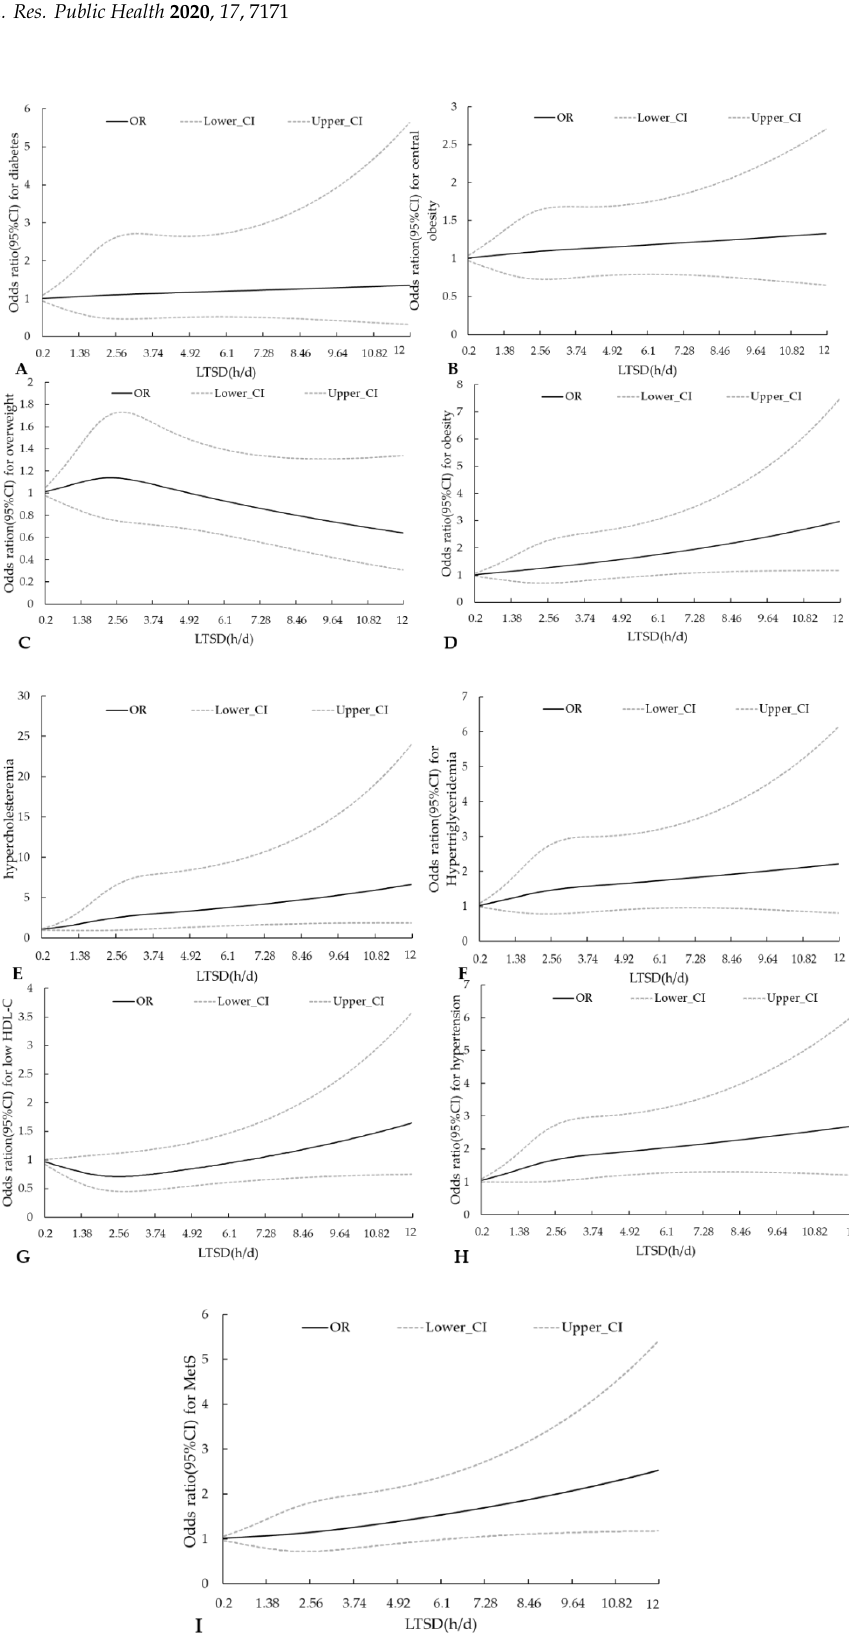
Figure 1. Restrictive cubic spline (RCS) curves for sedentary duration and ( A ) diabetes, ( B ) central obesity, ( C ) overweight, ( D ) obesity, ( E ) hypercholesterolemia, ( F ) hypertriglyceridemia, ( G ) low HDL-C level, ( H ) hypertension, and ( I ) metabolic syndrome (MetS). Region, education, income, alcohol consumption, exercise, daily energy intake, and fat energy ratio were adjusted for all RCS curves.